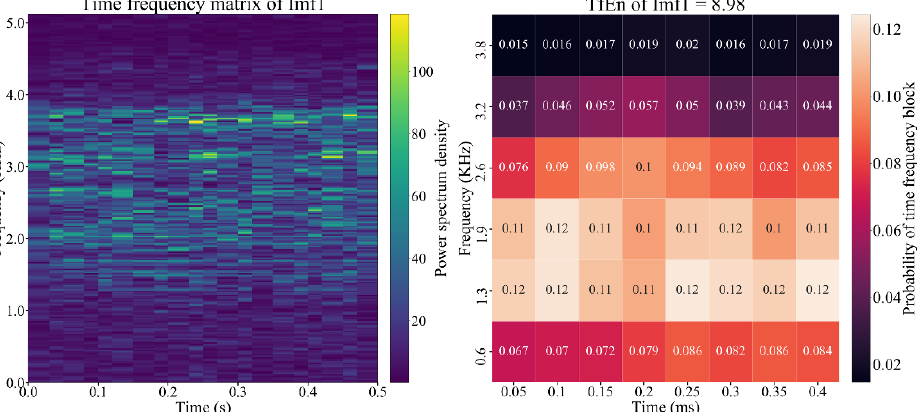
Figure 8. Two-dimensional time-frequency matrix ( left ); energy density matrix ( right ) under the normal mode.